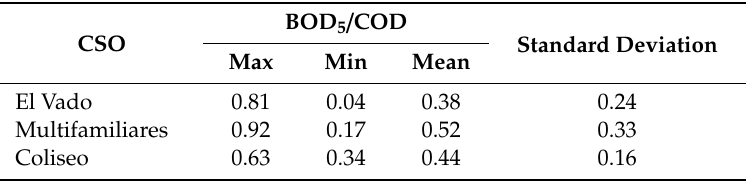
Table 2. The BOD 5 / COD ratio for the samples recorded throughout the study period of March 2017 to May 2018. BOD 5 / COD CSO Standard Deviation Max Min Mean El Vado